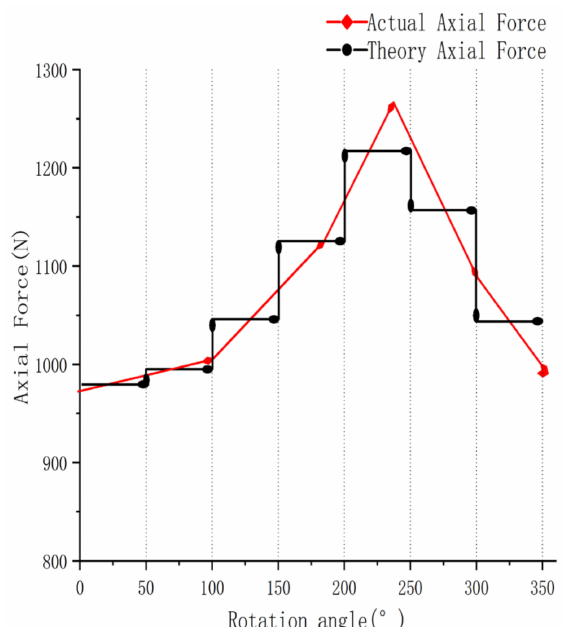
Figure 6. End of tracking.